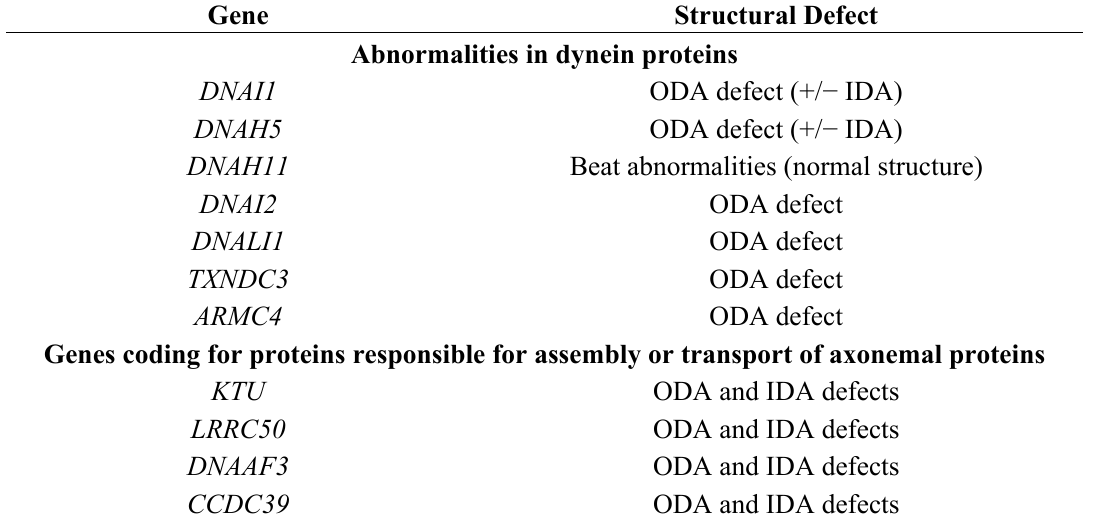
Table 1. Genes with mutations linked to primary ciliary dyskinesia. ODA—outer dynein arms, IDA—inner dynein